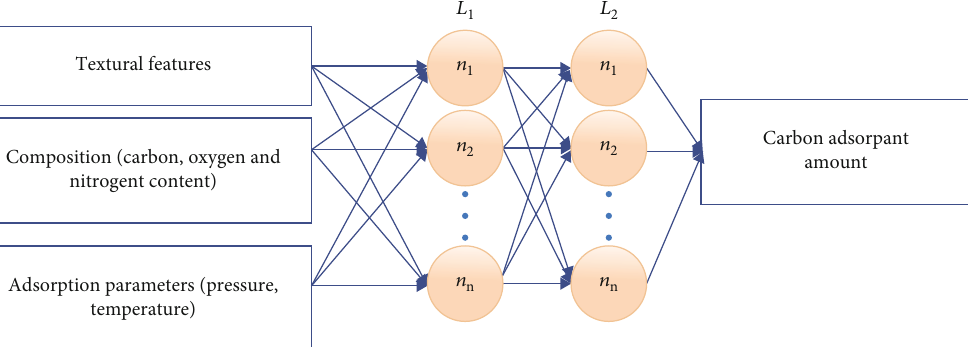
Figure 2: The deep learning model consists of many phases. The fi rst phase is mainly to identify and gather data items based on the following parameters such as textural composition and adsorption parameters. The next phase is to input these data into the network training